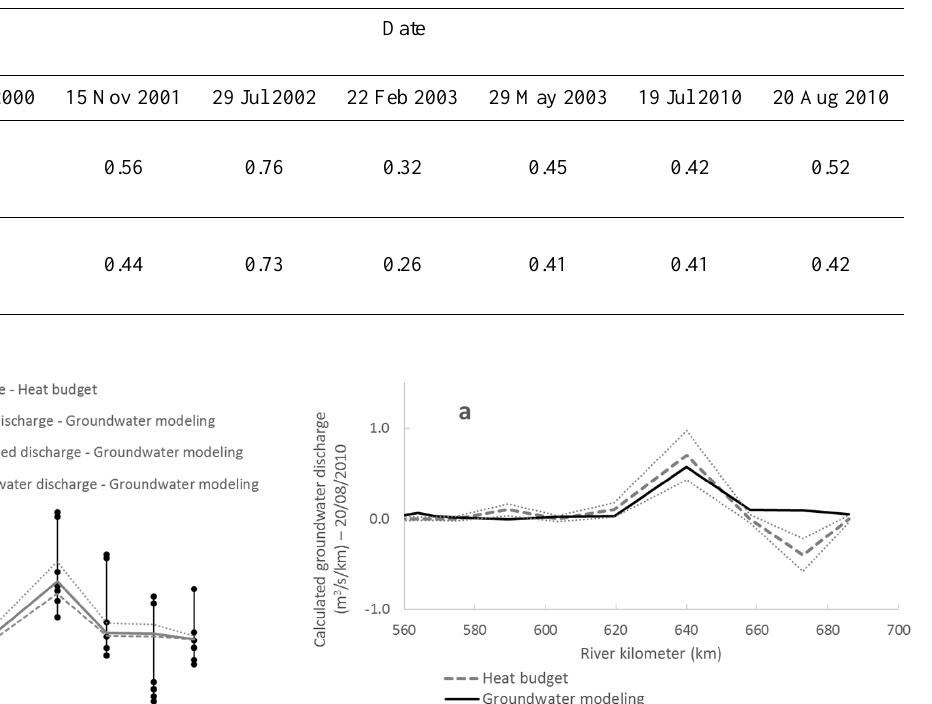
Table 3. Standard deviation of water temperature ( ◦ C) estimated on all the 200m sections of the Loire River. Standard deviations were calculated at sections with under 20 water pixels and over 20 water pixels.